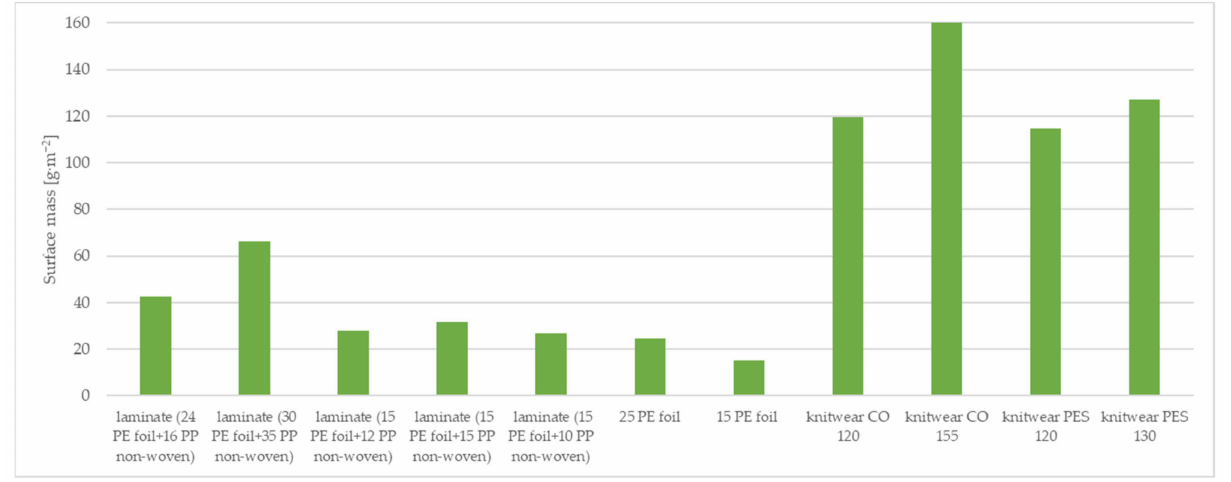
Figure 5. Surface mass of tested materials.